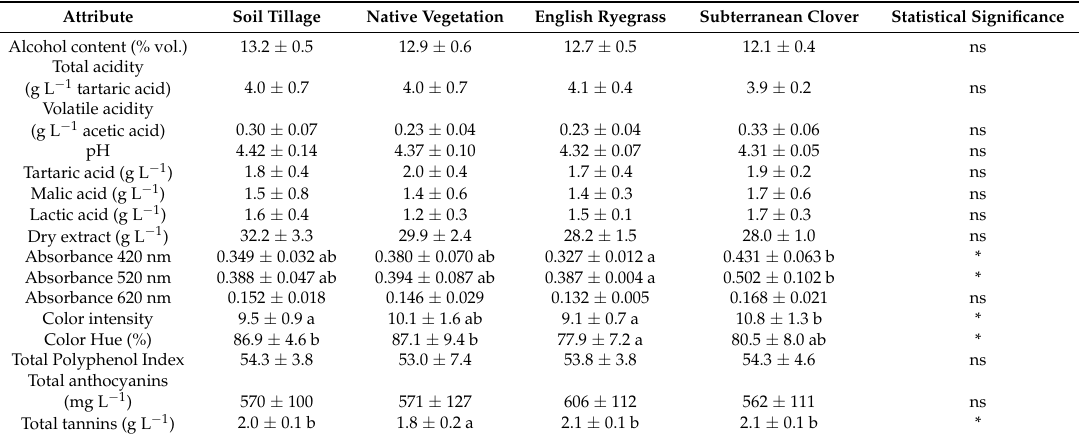
Table 2. General parameters of Menc í a wines for the different soil management treatments after five months bottled and averaged for three seasons (2012–2014). Data are averages ± standard errors. Attribute Soil Tillage Native Vegetation Alcohol content (%